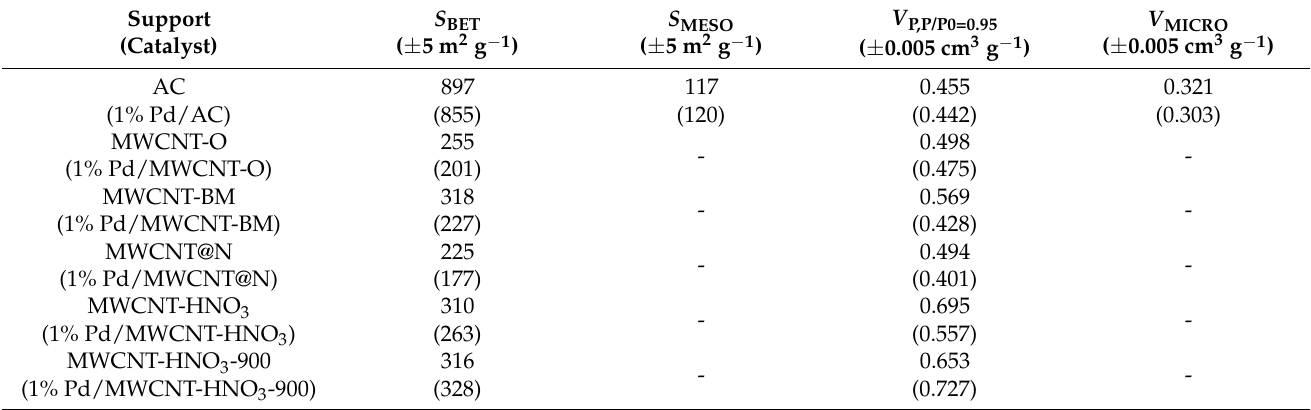
Table 2. Relevant textural and chemical properties of the selected carbon supports and respec- tive nanocatalysts.